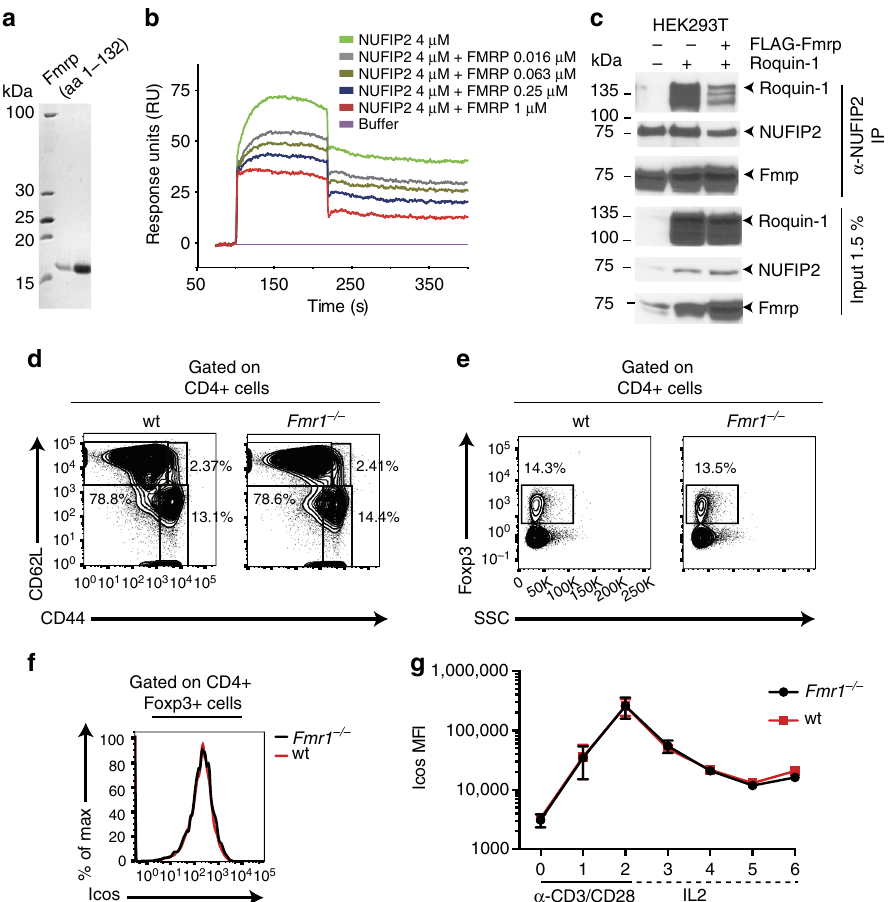
Fig. 6 Mutually exclusive interaction of Nu fi p2 with Fmrp or Roquin. a Representative coomassie-stained PAGE of puri fi ed mFmrp (aa 1 – 132). b Biacore sensogram recording of the binding of NUFIP2 (aa 255 – 441) injected at 4 μ M to surface-coupled Roquin-1 (aa 2 – 441) in the presence of increasing amounts (0.016 – 1 μ M) of Fmrp (aa 1 – 132). The quality of Biacore experiments was assessed by two independent injections of 1 µ M Fmrp and 4 µ M NUFIP2 at different time points during each experiment. c Immunoprecipitation of endogenous NUFIP2 from lysates of HEK293T cells that were transiently transfected with Roquin-1 with or without co-transfection of FLAG-Fmrp using a monoclonal Nu fi p2 antibody. Immunoblot analysis to detect Nu fi p2, Fmrp and Roquin-1/2 after Nu fi p2 immunoprecipitation (IP) is shown. d – g Analysis of splenic CD4 + T cells from wild-type (wt) and Fmrp-de fi cient ( Fmr1 − / − ) mice. d , e Flow cytometry analysis of CD4 + T cells showing naive (CD62L hi CD44 lo ), effector-memory (CD62L lo CD44 hi ), or central-memory (CD62L hi CD44 hi ) ( d ) or e Foxp3 + Tregs among CD4 + pre-gated T cells. f Flow cytometry analysis of ICOS expression on the surface of Foxp3 + splenic CD4 + T cells. g Quanti fi ed ICOS expression on CD4 + T cells isolated from Fmrp-de fi cient or wild-type mice in a 6-day in vitro culture. One representative of two ( c ) or three ( b ) independent experiments are shown in b and c . In d – f data are representative of four mice per genotype and g shows mean and SD of four